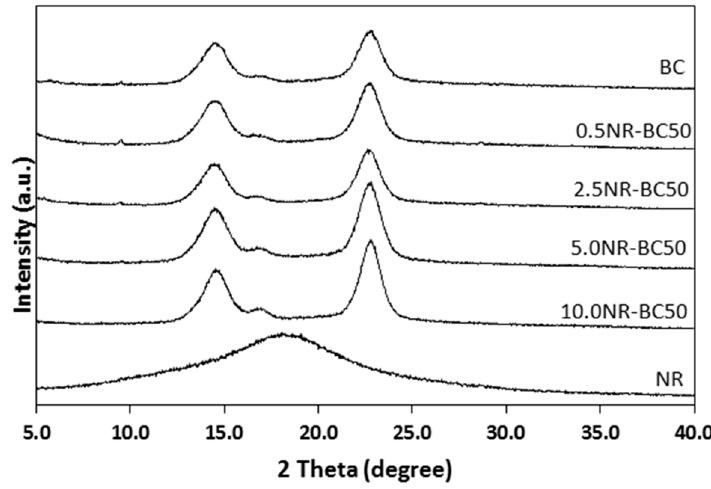
Figure 7. X-ray diffraction (XRD) patterns of BC, NR, and NR–BC films treated by the immersion in NRL of various concentrations at 50 °C.